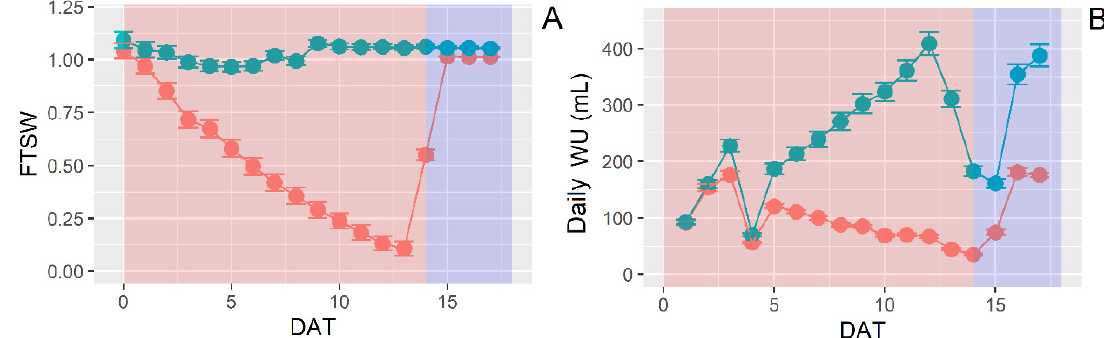
Figure 3. (A ) Average fraction of transpirable soil water (FTSW) for WW (blue dots) and WS (red dots) during the experimental period. ( B ) Daily WU for WW (blue dots) and WS (red dots) during the experimental period. DAT represents days after water stress application. Red background in the graphs represents stress application to WS pots while blue background represents the recovery period. Data are means ( n = 6–9) ± standard error of the means.